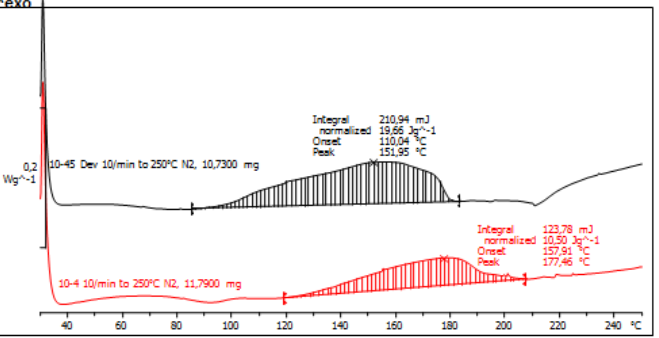
Figure 7. DSC analysis of two truly devulcanized rubber compounds showing the respective re- vulcanization exotherms. On the other hand, the conventional reclaiming process of the rubber compound, which has been a consolidated industrial practice since the first half of the previous cen- tury, is based on the indiscriminate administration of mechanical energy to the cured rub- ber compound. The amount of energy administered is so large that inevitably there is a complete oxidative breakdown of the rubber chains backbone together with the sulfur crosslinks. The reclaimed compound obtained is necessarily much softer than the starting recycled compound (also as a result of the use of softeners and processing aids) and once tested in a DSC analysis as shown in Figure 8, it does not give any exothermal signal in- terpretable as a re-vulcanization process. In fact, in Figure 8 a reclaim sample gives at DSC just a very weak exotherm of only 1.2 J/g with peak shifted at 190 °C, while the other reclaim gives only an endothermal peak at 186 °C (probably due to the melting of certain processing aids used for the reclaim process).